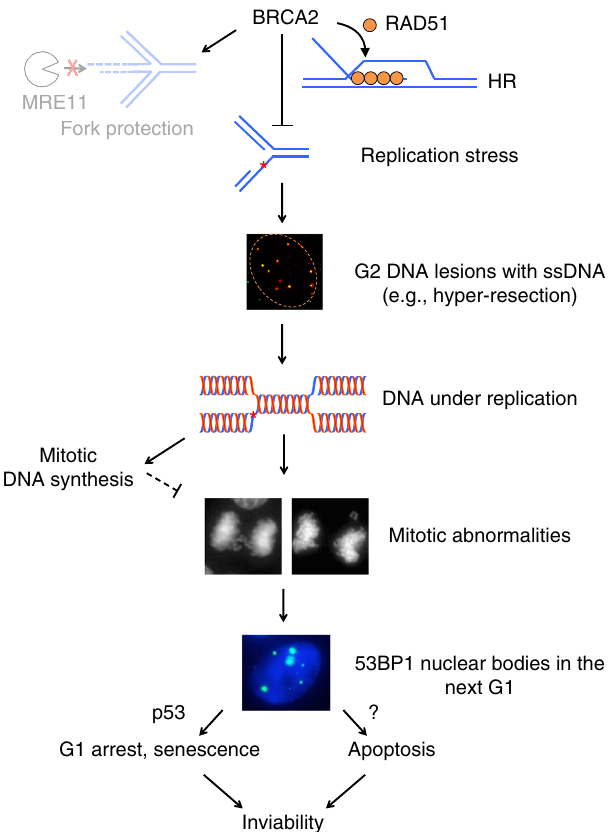
Fig. 9 Model for replication stress and its aftermath in the absence of BRCA2. BRCA2 suppresses replication stress and DNA under replication in non-transformed cells primarily through RAD51-mediated HR repair of DNA damage. Protection of stalled replication forks from MRE11-mediated degradation plays a minor role. Upon BRCA2 de fi ciency, single-stranded DNA lesions accumulate in G2, generated, in part, by fork reversal (not shown) and hyper-resection. Unrepaired DNA damage perturbs the timely completion of DNA replication, leading to under replication. During early mitosis, the compensatory mitotic DNA synthesis pathway is insuf fi cient, such that these unresolved DNA structures lead to anaphase abnormalities and formation of 53BP1 nuclear bodies in the next G1 phase. G1 arrest and cellular senescence mediated by p53 and p53-independent apoptosis are in turn triggered to ultimately result in cell